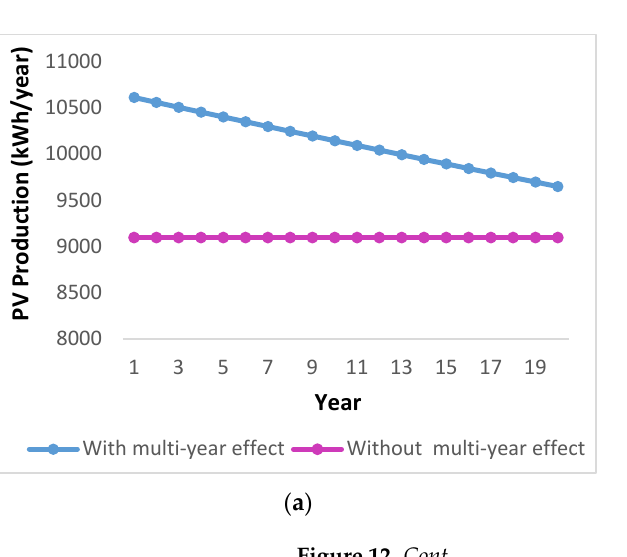
Figure 11. Year-year analysis for; ( a ) PV production; ( b ) Grid purchases; ( c ) Battery output energy; ( d ) CO 2 emissions, using LF strategy.